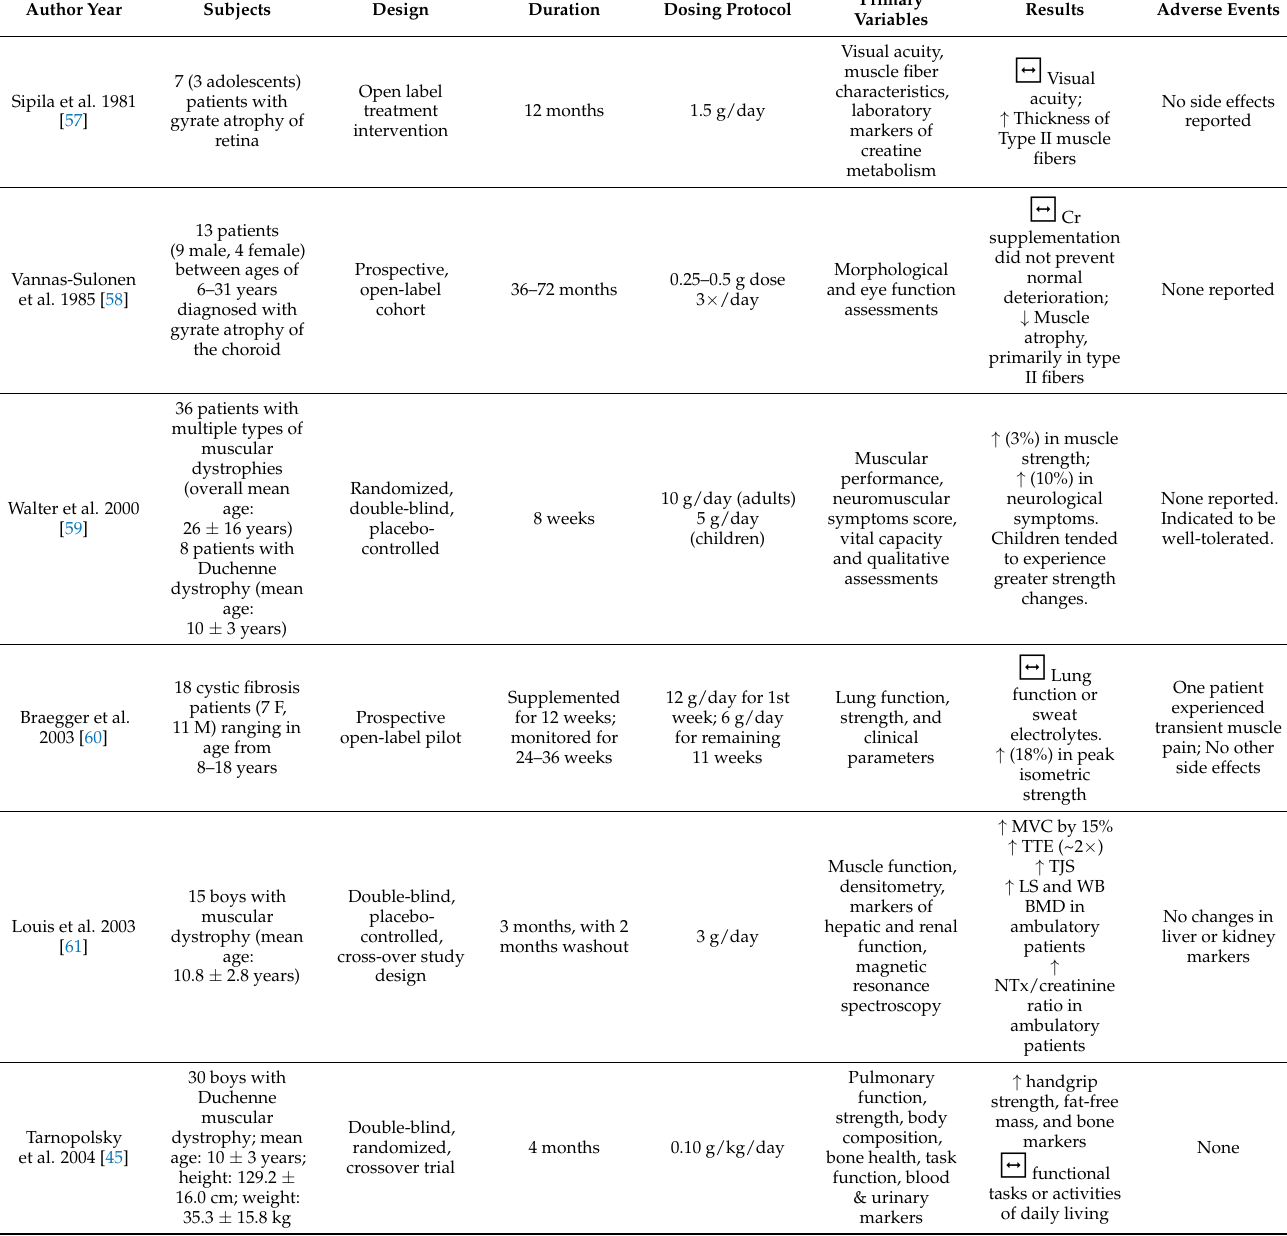
Table 2. Efficacy of creatine in clinical settings.